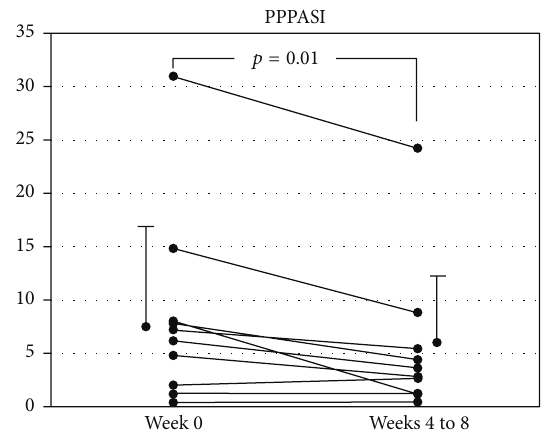
Figure 2: The PPPASI in patients with PPP before and after treatment with JHT. These indices were significantly decreased after JHT treatment ( 𝑝 = 0.01